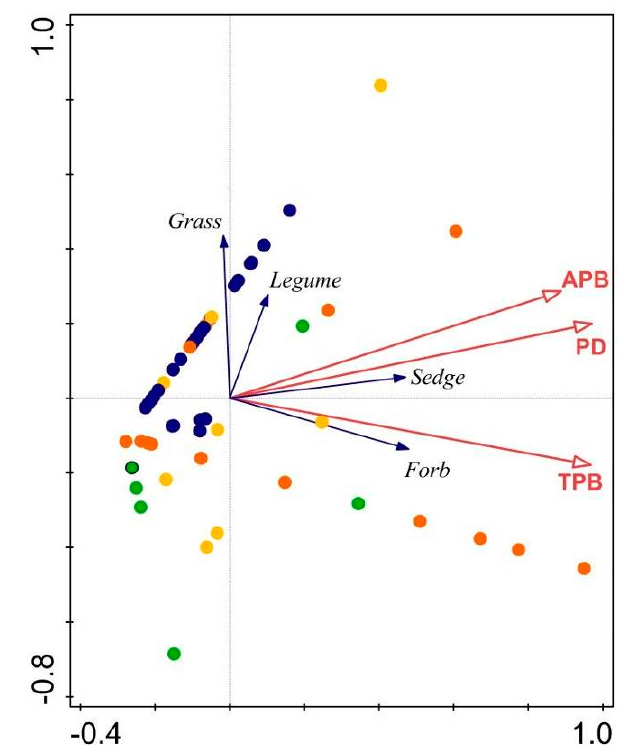
Figure 11. Redundancy analysis (RDA) triplot presenting the relationship of vegetation species richness of functional groups with pika burrows and pika density. The blue solid arrows are vegetation species richness of functional groups. The hollow red arrows are pika burrows and pika density. Green, orange, yellow and blue solid cicles are all plots for vegetation species richness of functional groups investigating in the alpine swamp meadow, alpine meadow, alpine steppe meadow and alpine steppe, respectively. TPB, APB and PD are total pika burrows, active pika burrows and pika density, respectively.